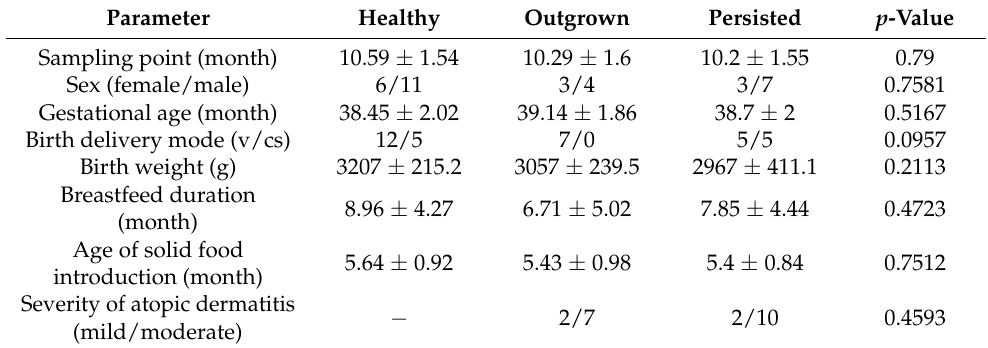
Table 2. Clinical characteristics of